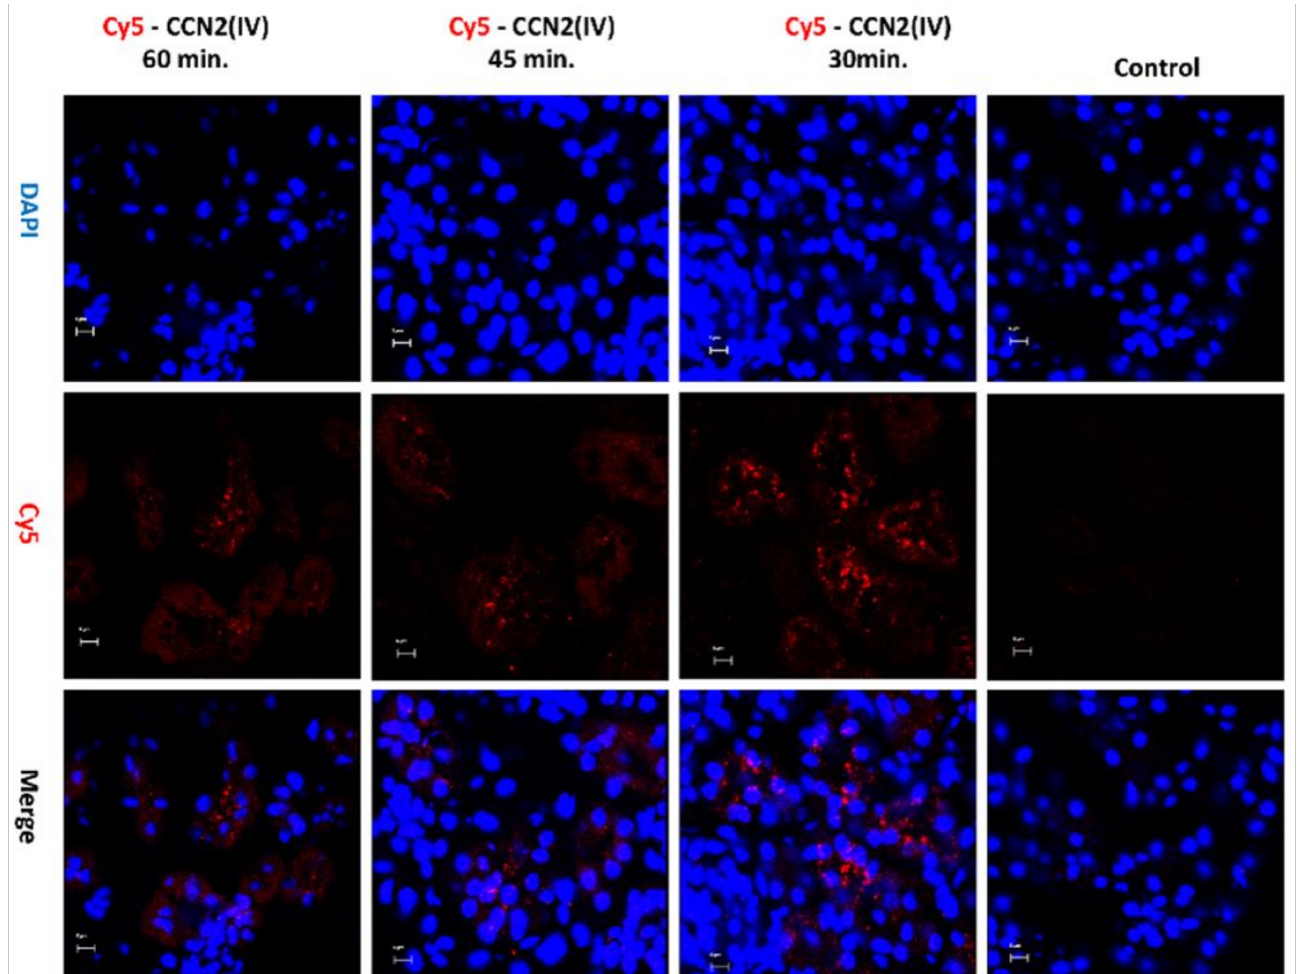
Figure 3. Evaluation of CCN2(IV) binding to the kidney in the model of systemic administration in mice. C57BL/6 mice were i.p. injected with 2.5 ng/g of body weight of recombinant Cy5- CCN2(IV) and sacrificed 30, 45, and 60 min later. In the kidneys from Cy5-CCN2(IV)-injected mice, red immunostaining corresponding to CCN2(IV) labeled with Cy5 fluorophore (red staining) was observed by confocal microscopy. Nuclei were stained with DAPI to locate renal structures. The overlaid images in red and blue (merge) indicated CCN2 (IV) localization mainly in the membrane of tubular epithelial cells. Figures show a representative mouse per group of 3 done, and scale bar represents 5 µ M.